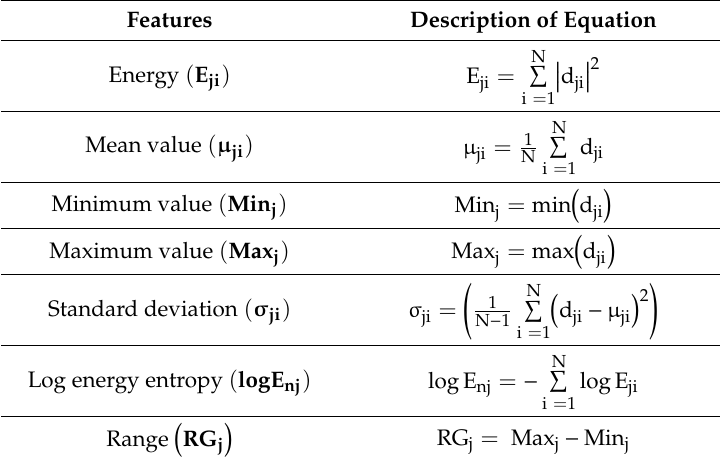
Table 4. Equations for statistical feature